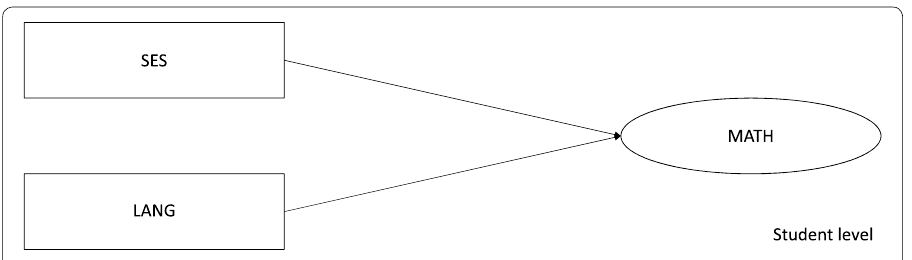
Fig. 3 Direct link between background characteristics and achievement (basis for moderation